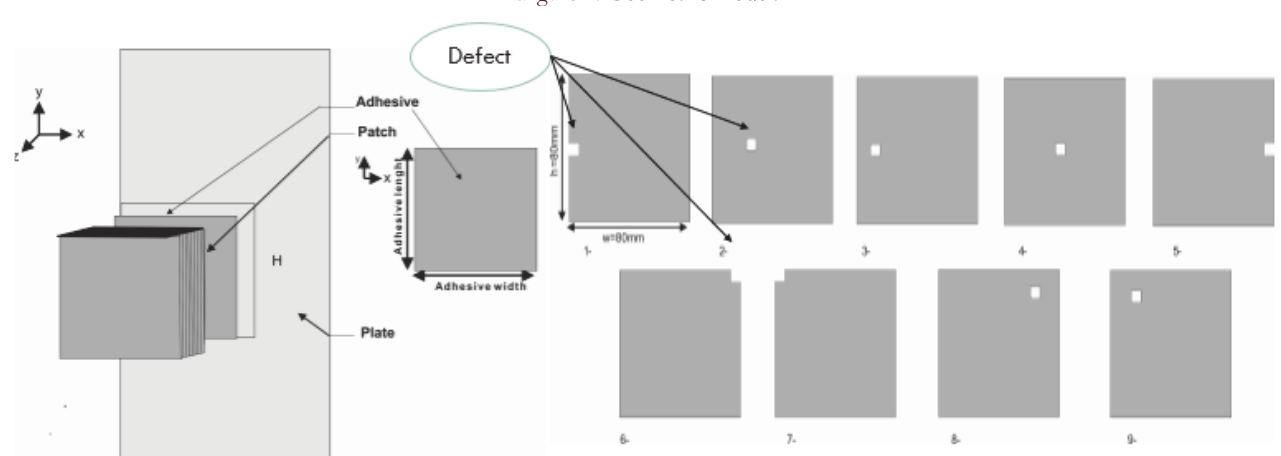
Figure 1: Geometric model.